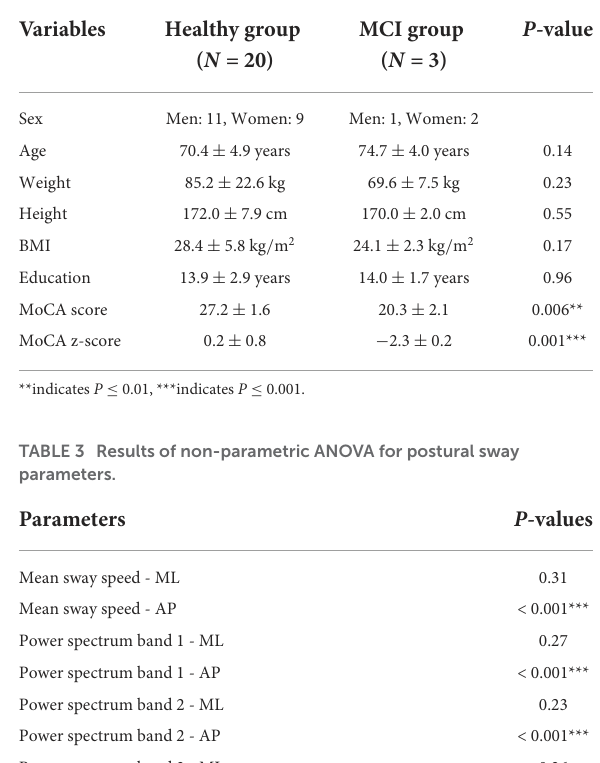
TABLE 2 Demographic profile of participants in the experiment.